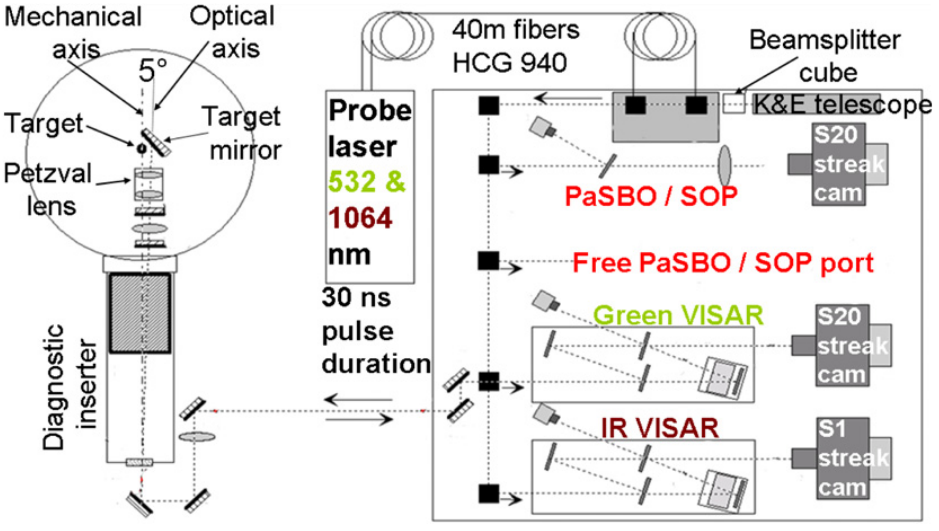
Figure 2. VISAR diagnostic